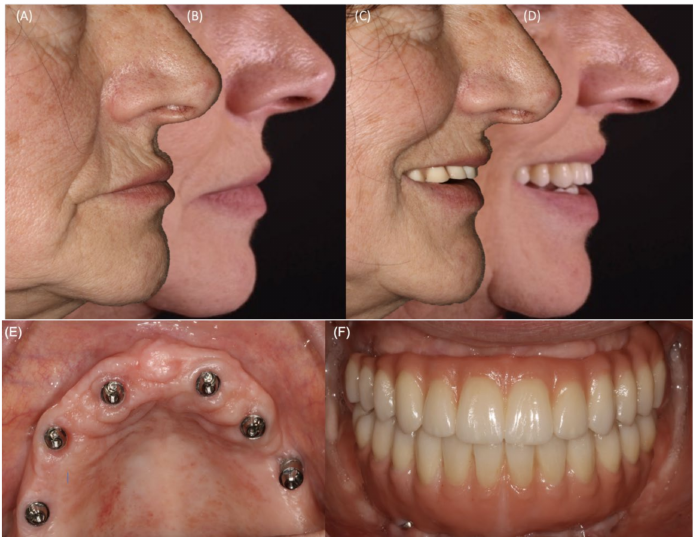
Figure 4. Clinical photographs reporting the relevance of the issue presented in this study. Evaluation of the aesthetic features related to lip support and prosthesis, as well as soft tissue healing and emergence profile at the 12-month follow-up appointment. ( A ) Lip support at rest before treatment; ( B ) Lip support at rest at the 12-month follow-up appointment; ( C ) Lip support at smiling position before treatment; ( D ) Lip support at smiling position at the 12-month follow-up appointment; ( E ) Emergency profile of the six implants placed in the maxilla. ( F ) Superior and inferior full-arch prosthesis in monolithic zirconia. Note that the maxillary prosthesis included a very reduced buccal flange due to the hard and soft regeneration obtained after